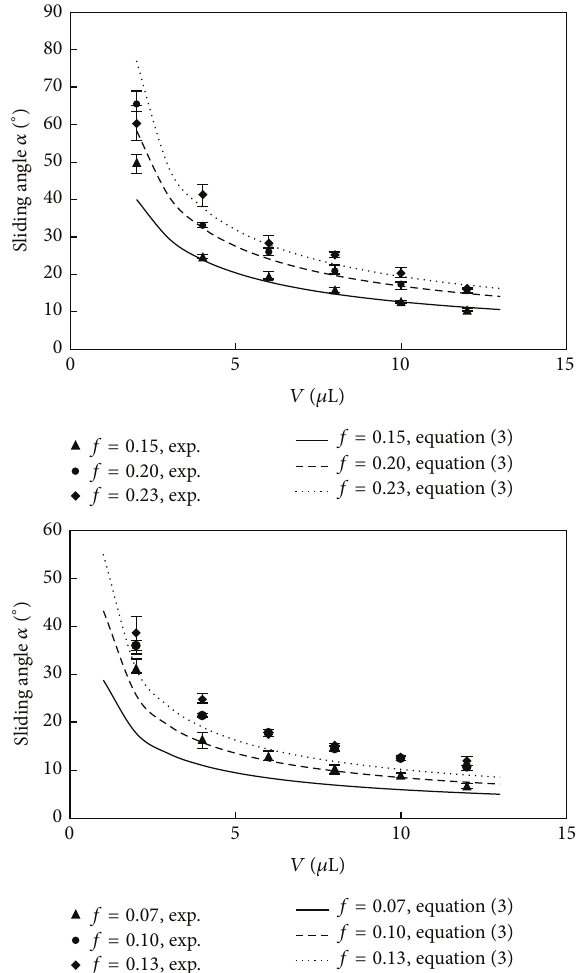
Figure 7: Comparison between experimental results and theoretical